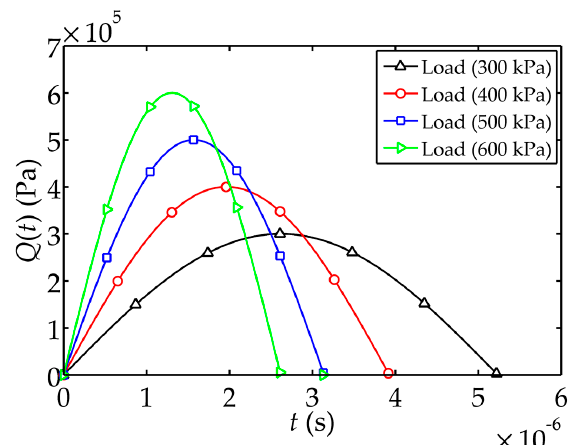
Figure 2. Schematics of the transient haversine wave load Q ( t ). Sensors 2017 , 17 , 2035